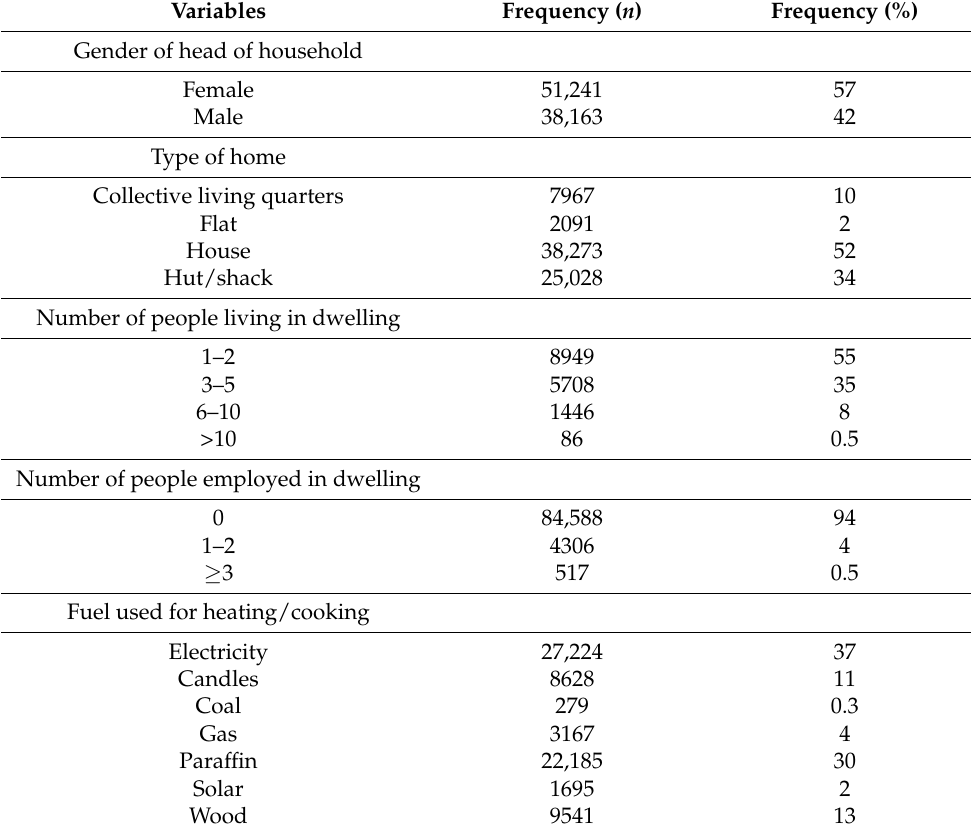
Table 1. Summary characteristics of households and dwellings for all households in the dataset. Percentage frequencies do not sum to 100% due to missing